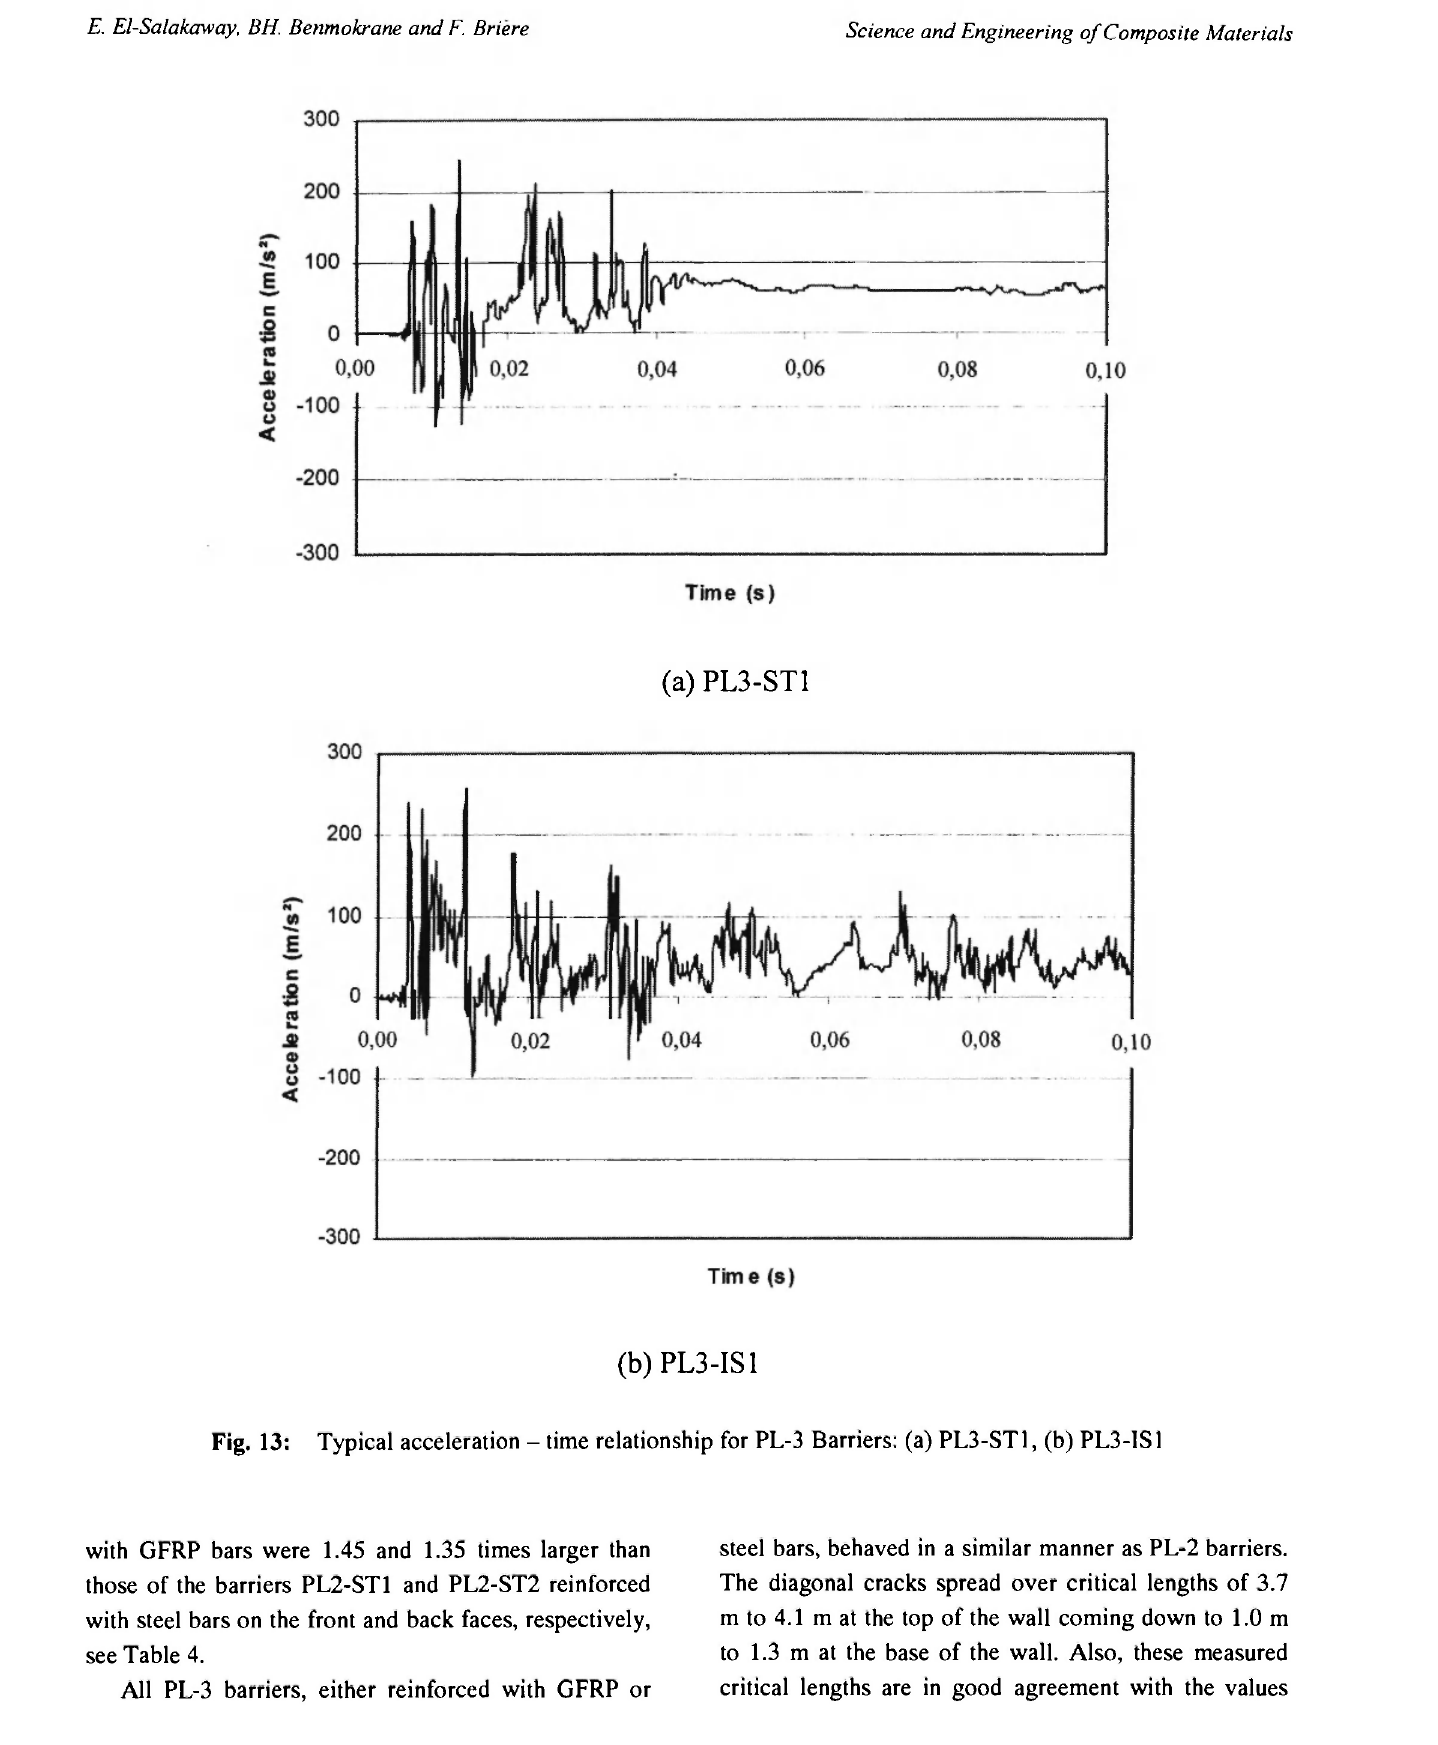
with GFRP bars were 1.45 and 1.35 times larger than those of the barriers PL2-ST1 and PL2-ST2 reinforced with steel bars on the front and back faces, respectively, see Table 4. All PL-3 barriers, either reinforced with GFRP or